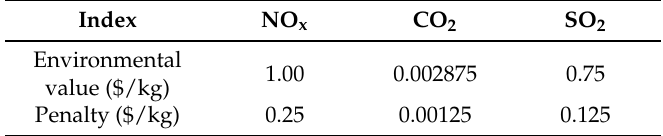
Table 3. Environmental value standard and penalty for pollutant